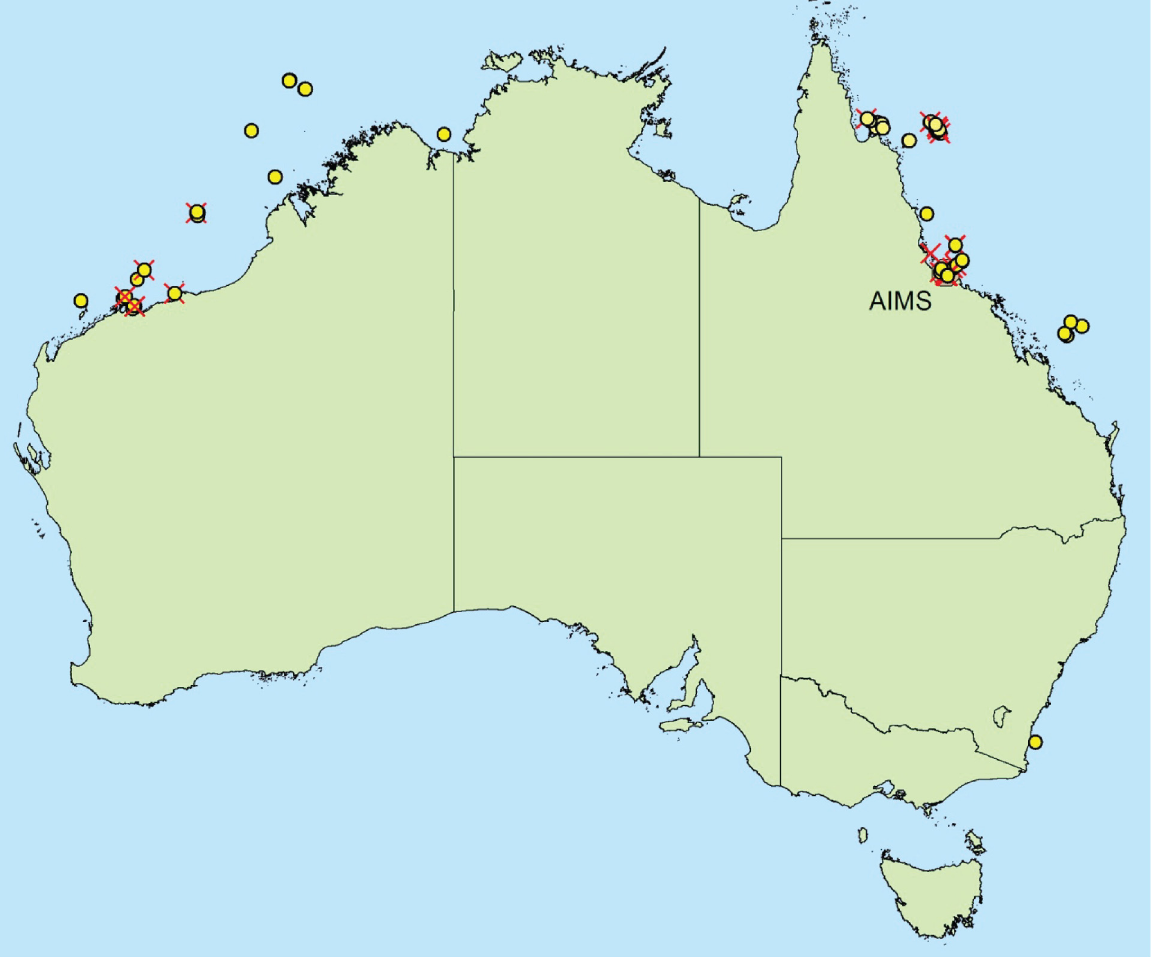
Fig 1. Specimen collection sites. Red crosses denote sites where unknown OTUs have been recovered. This figure was generated by the authors using ArcMap 10.1 with the Geodata Coast 100k base layer [74] available under creative commons 4.0